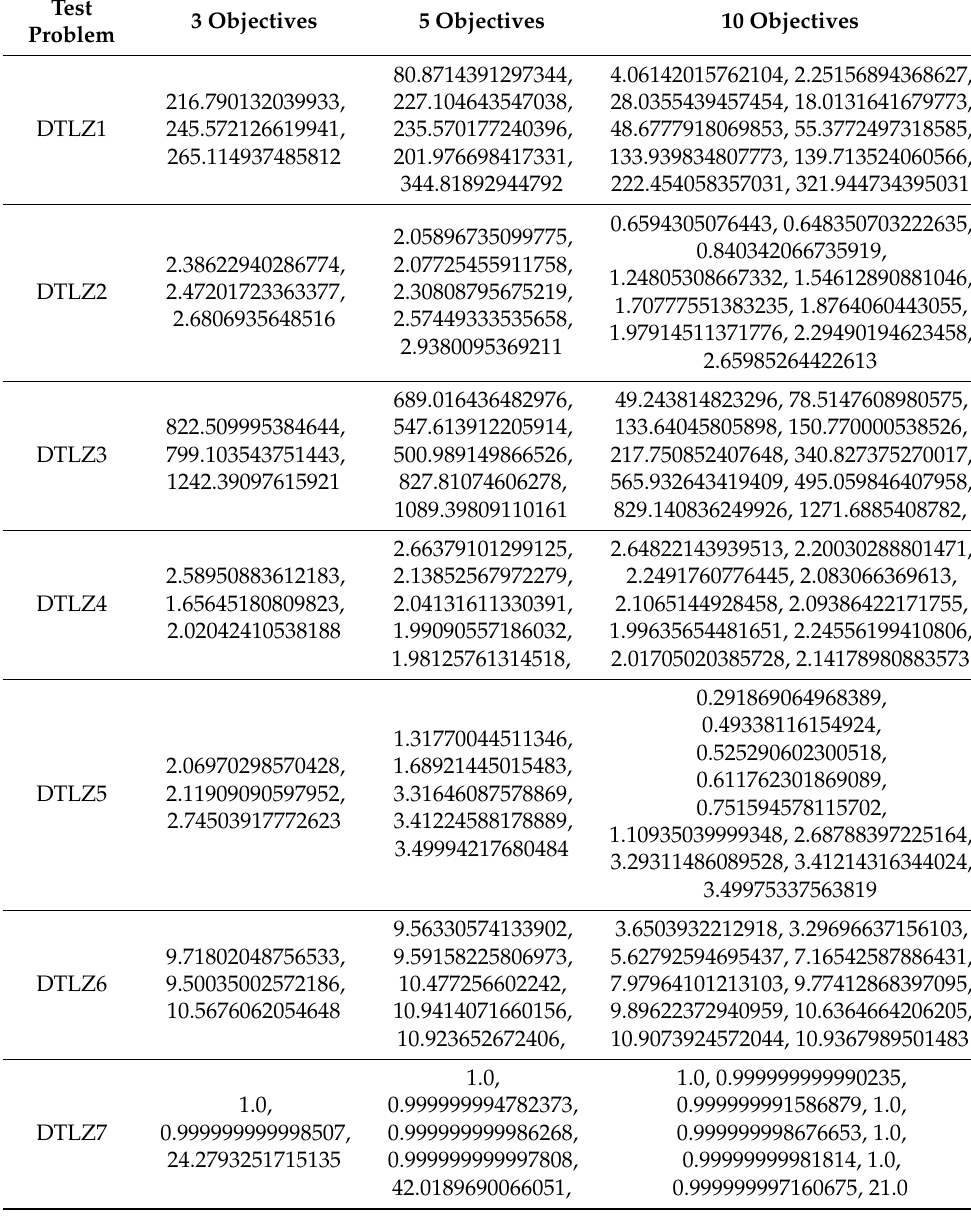
Table 4. Reference points for DTLZ problems used by HV